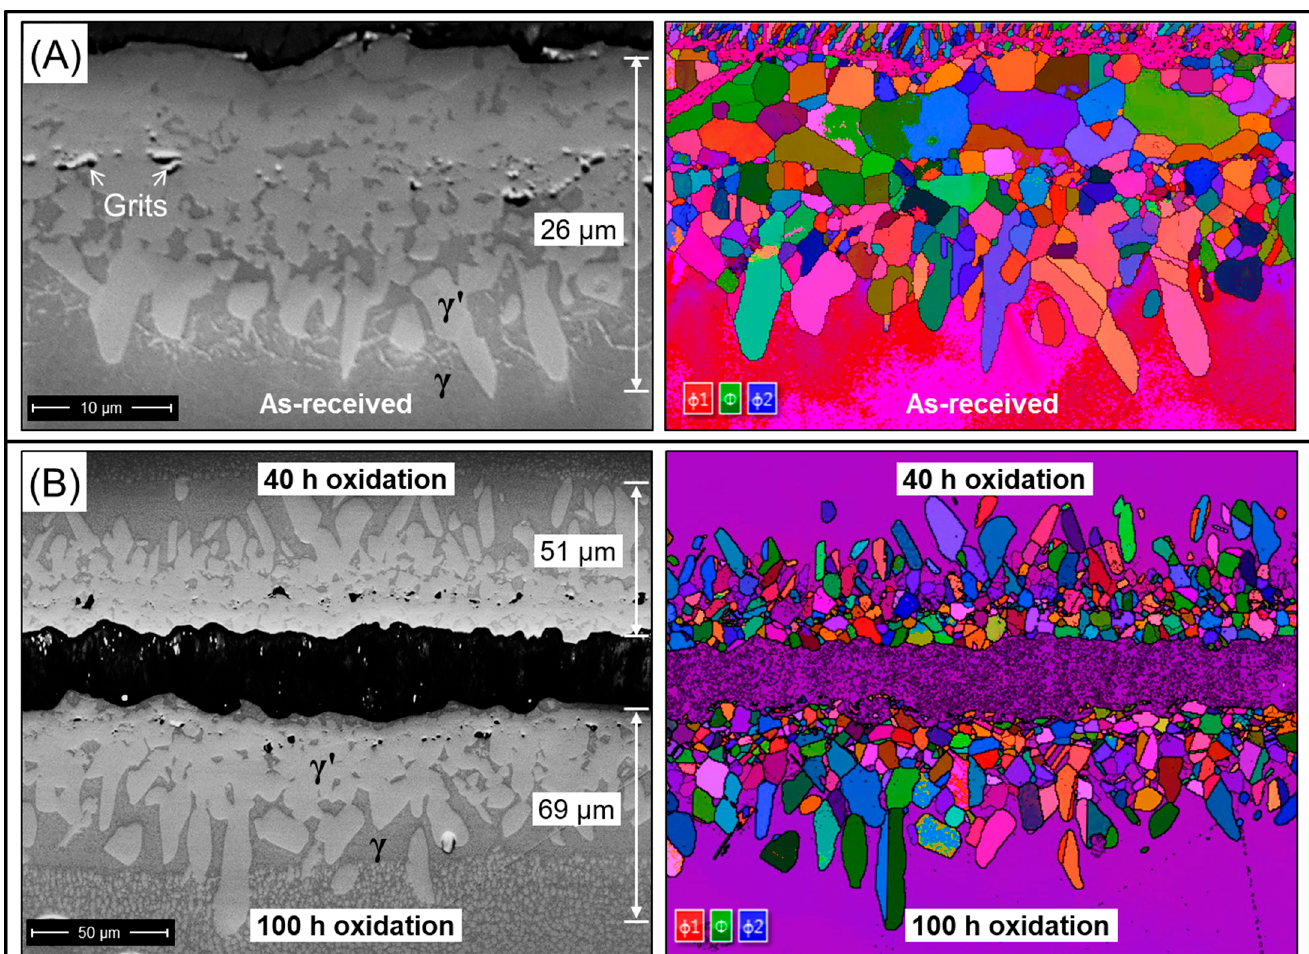
Figure 5. BSE imaging and EBSD Euler colour mapping of the cross-section of a Pt-diffused γ / γ ’ bond coat: ( A ) as-received; and ( B ) after oxidation at 1150 °C for 40 h (top) and 100 h (bottom).